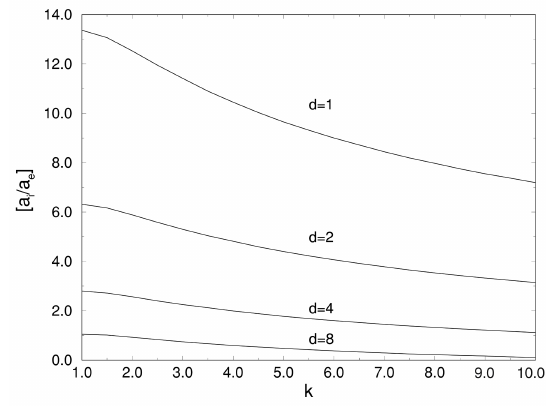
Fig. 1. Effect of disturbance penetration depth d and radius ratio k on a /a for elliptical shapes (a=2500). A decrease of a i e served for increasing d and